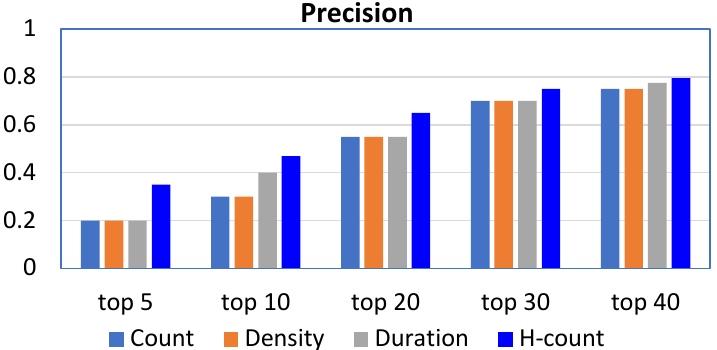
Figure 2. Precision comparison between H-Count and three baselines.